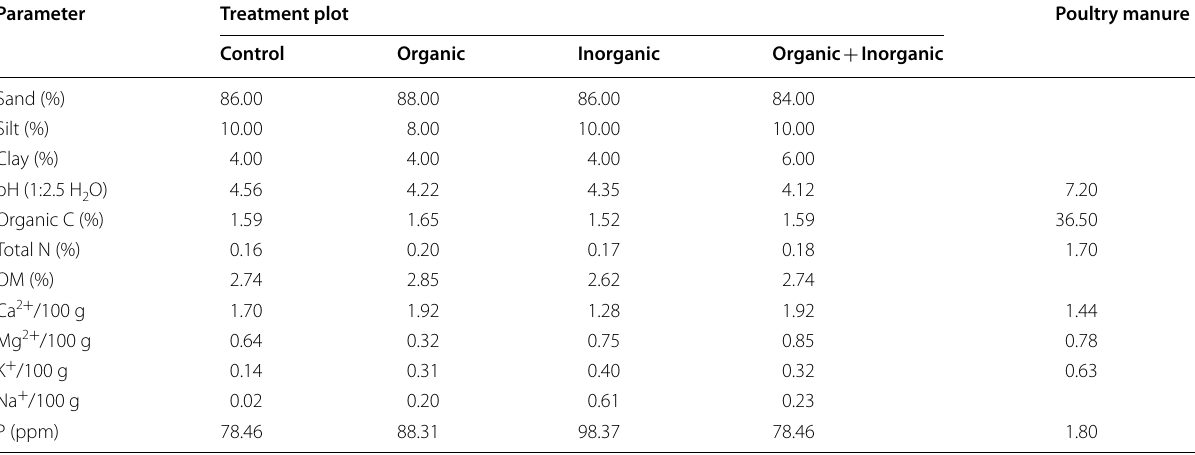
Table 1 Selected initial physical and chemical properties of soil and poultry manure. Source : Council for Scientific and Industrial Research-Soil Research Institute (CSIR-SRI), Kwadaso-Kumasi